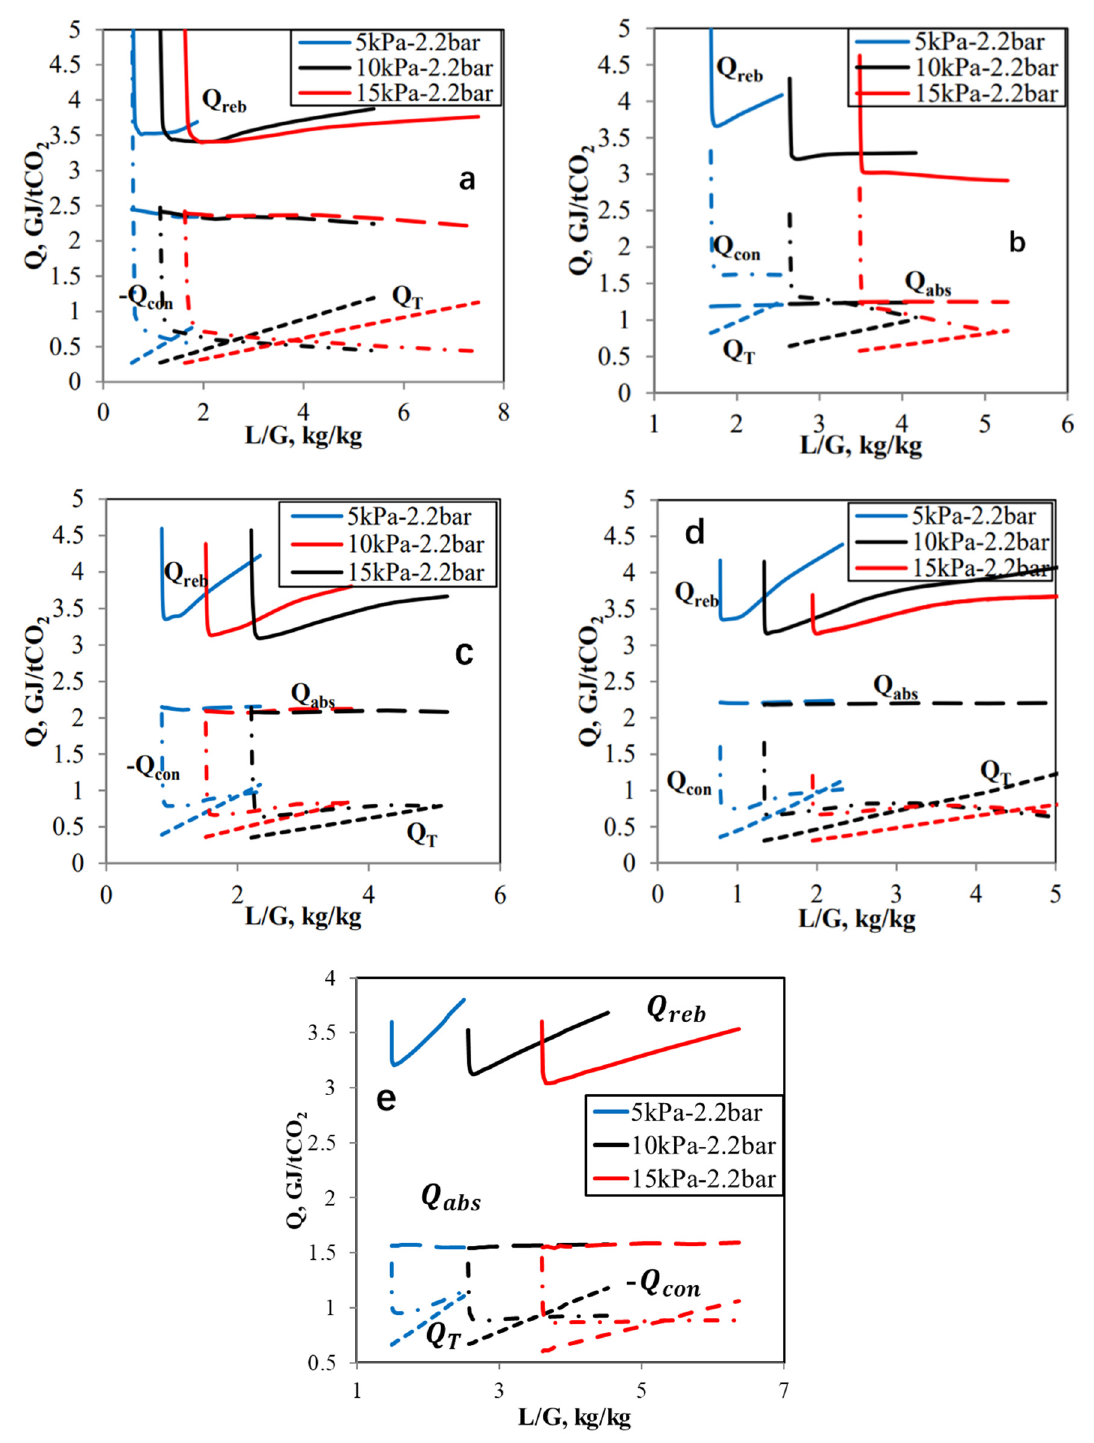
Figure 7. The effect of CO 2 partial pressure on the regeneration energy consumption of different solvents: ( a ) 40 wt.% MEA, ( b ) 30 wt.% DMEA, ( c ) 40 wt.% 1-MPZ, ( d ) 40 wt.% AMP and ( e ) 30 wt.% HEPZ.